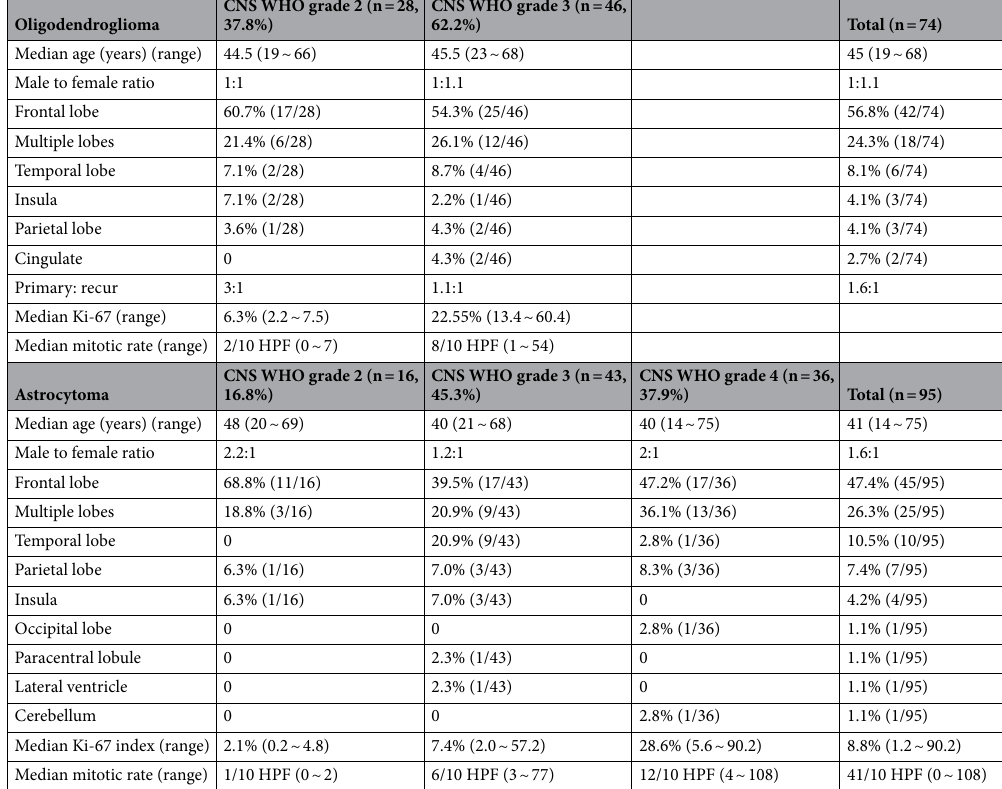
Table 1. Epidemiological summary and immunohistochemical result of studied IDH-mutant oligodendrogliomas and